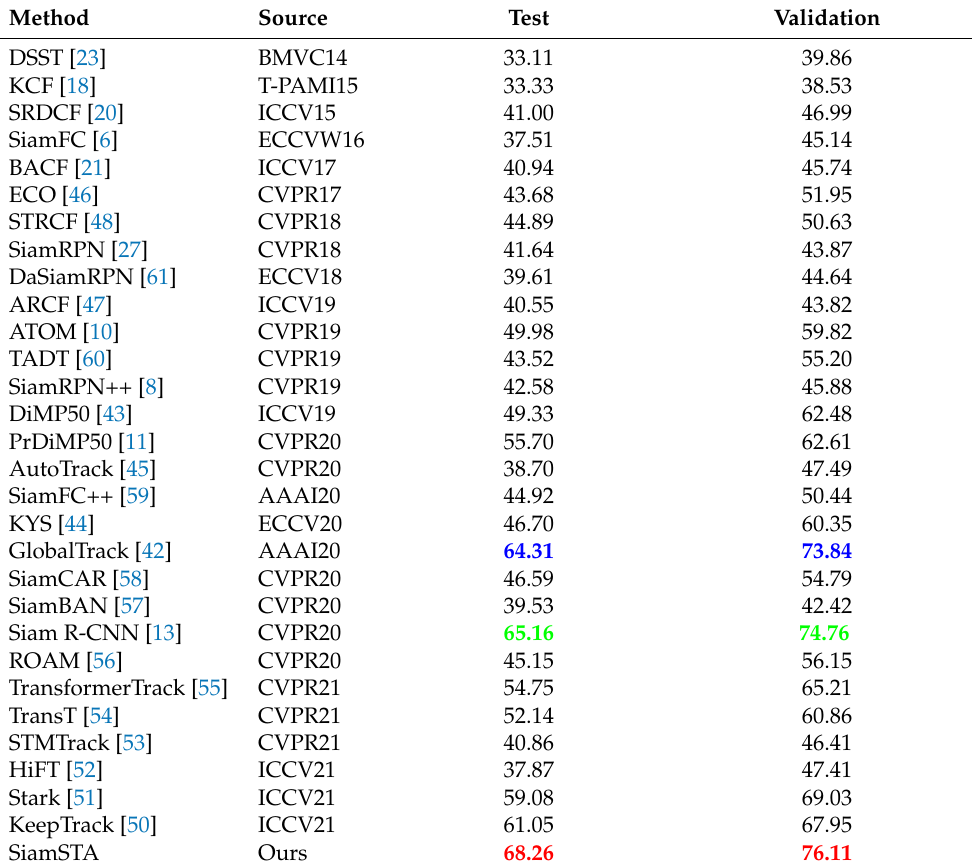
Table 1. The overall average accuracy (%) of state-of-the-art trackers on Anti-UAV test and validation sets. The top three results are highlighted in red, green and blue,